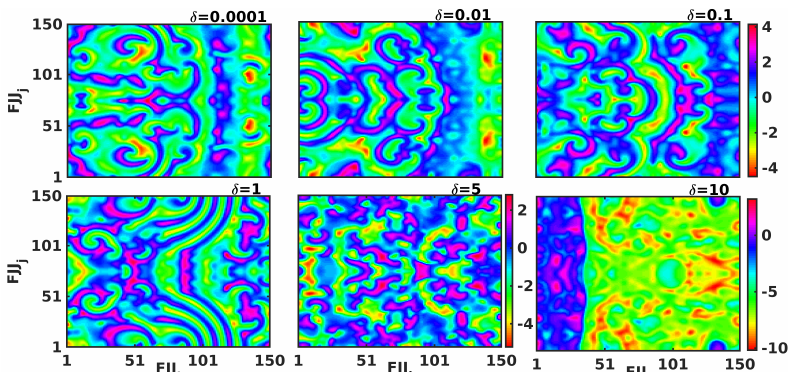
Figure 9. The energy of a network by fixing the variance of the BM noise as different values, δ = 0.0001, δ = 0.01, δ = 0.1, δ = 1, δ = 5, and δ = 10. Other parameter values are defined as D = 1.0, A = 5.0, q = 0.98, and d =